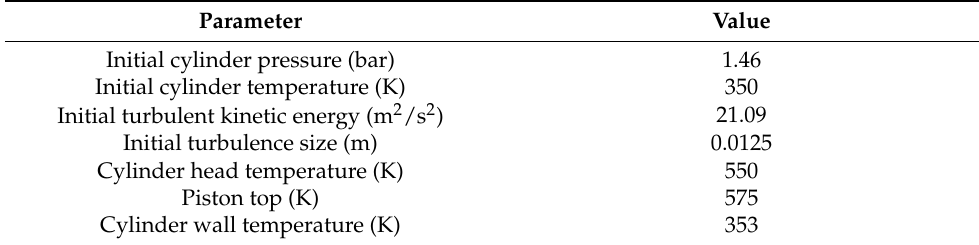
Table 2. Boundary and initial conditions according to the